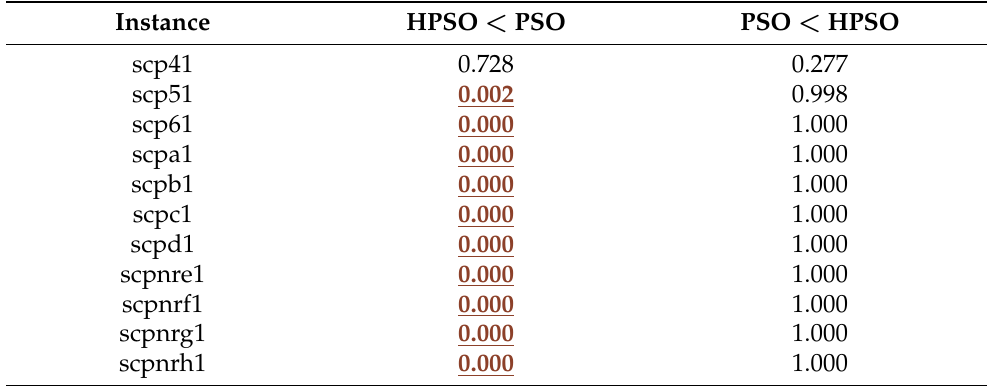
Table 4. Statistical